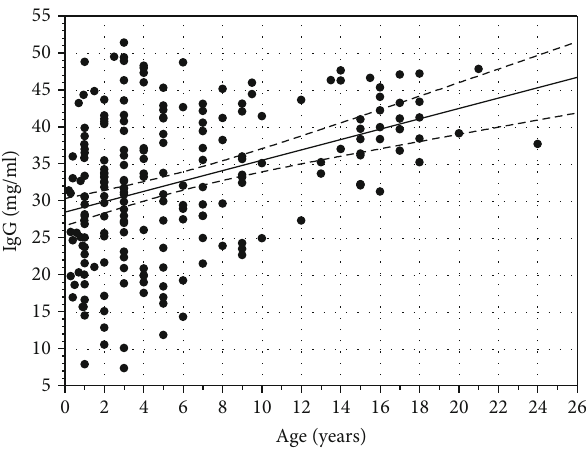
Figure 3: Relationship between absolute concentration of IgG in serum and age of European bison. Dotted lines represent 95% con fi dence intervals ( R Spearman = 0 : 376 , p = 0 : 0005 ).